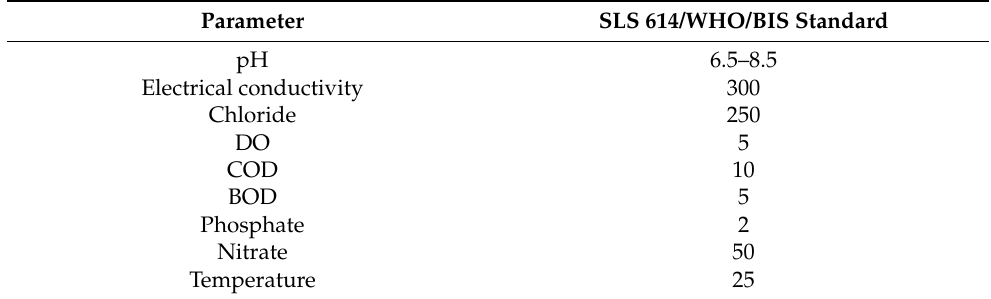
Table A1. Surface water pollution standards based on Sri Lankan water quality standards (SLS 614), WHO Standards, and BIS Standards.